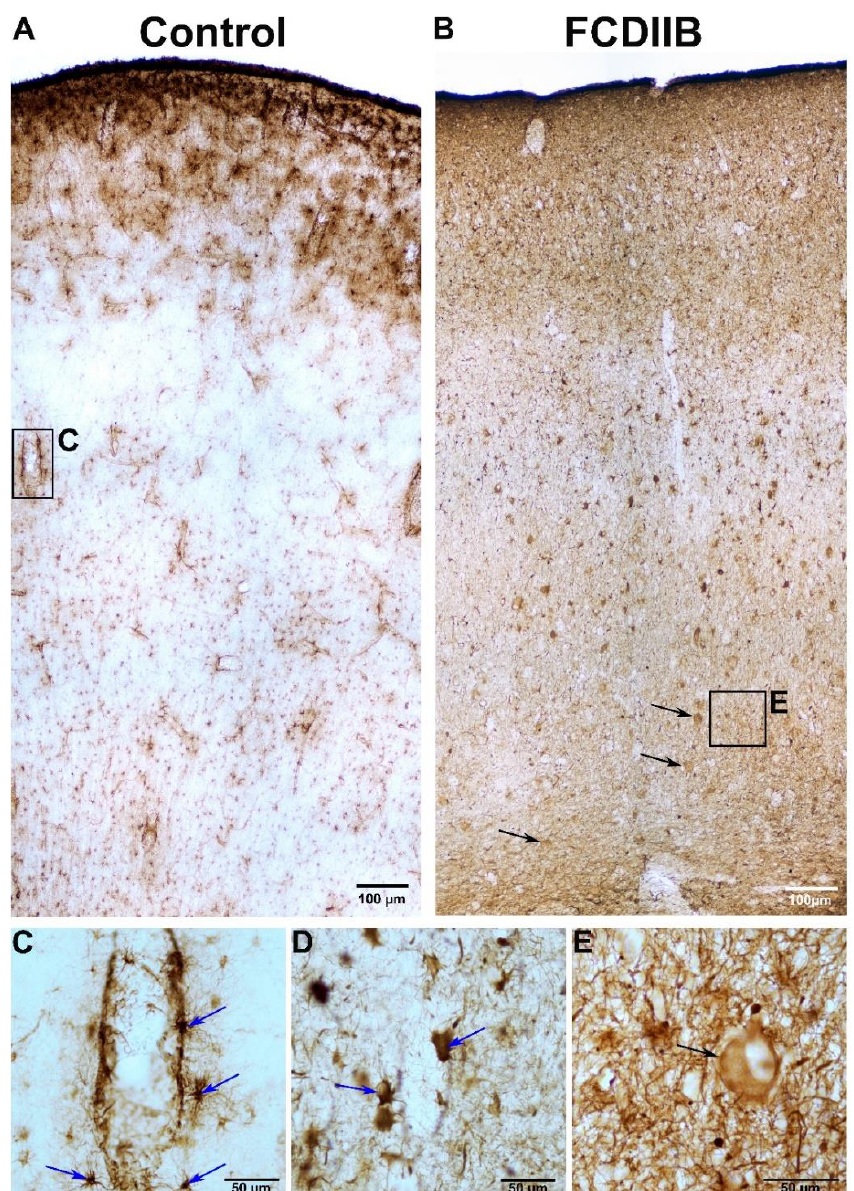
Figure 2. Glial fibrillary acidic protein (GFAP)-immunopositive elements in a control sample ( A , C ) and in an epileptic patient with FCDIIB in the frontal cortex ( B , D , E ). In the control sample, GFAP- labeled glial cells show loose distribution except in the first layer ( A ) and they are more frequent around blood vessels ( A , C ). Blue arrows show the GFAP-immunopositive glial cells (astrocytes). The amount of GFAP-immunopositive elements are increased in the dysplastic cortex ( B , D ). Both the number of cells and-their processes are also increased (gliosis) ( B , D ) compared to the control sample ( A , C ). The astrocytes are abnormally large, their processes are thicker and shorter ( D ). There are presumable balloon cells in the white matter and layer VI ( E ). Black arrows show the GFAP- immunopositive presumable balloon cells ( B , E ). Scales: ( A , B ): 100 µ m ( C – E ): 50 µ m, focused